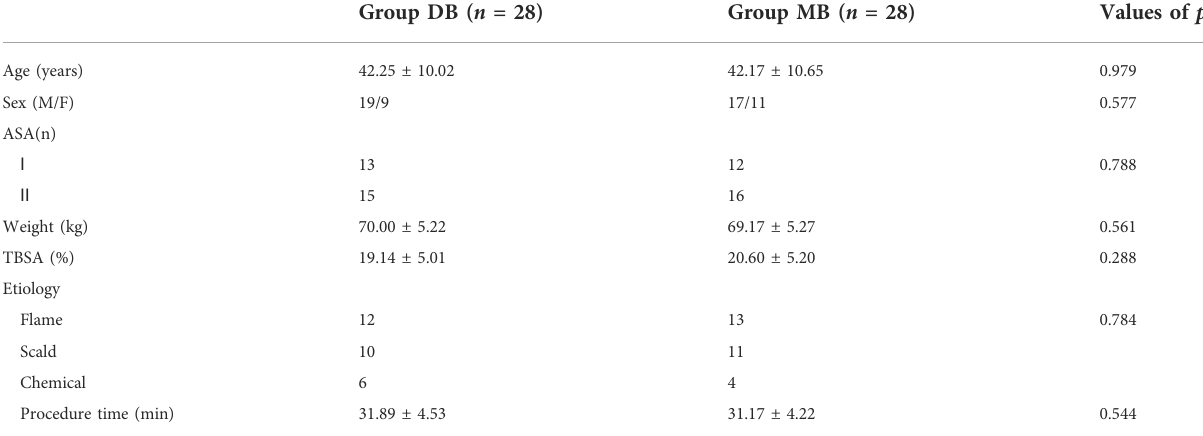
TABLE 1 Demographic data of the trial.